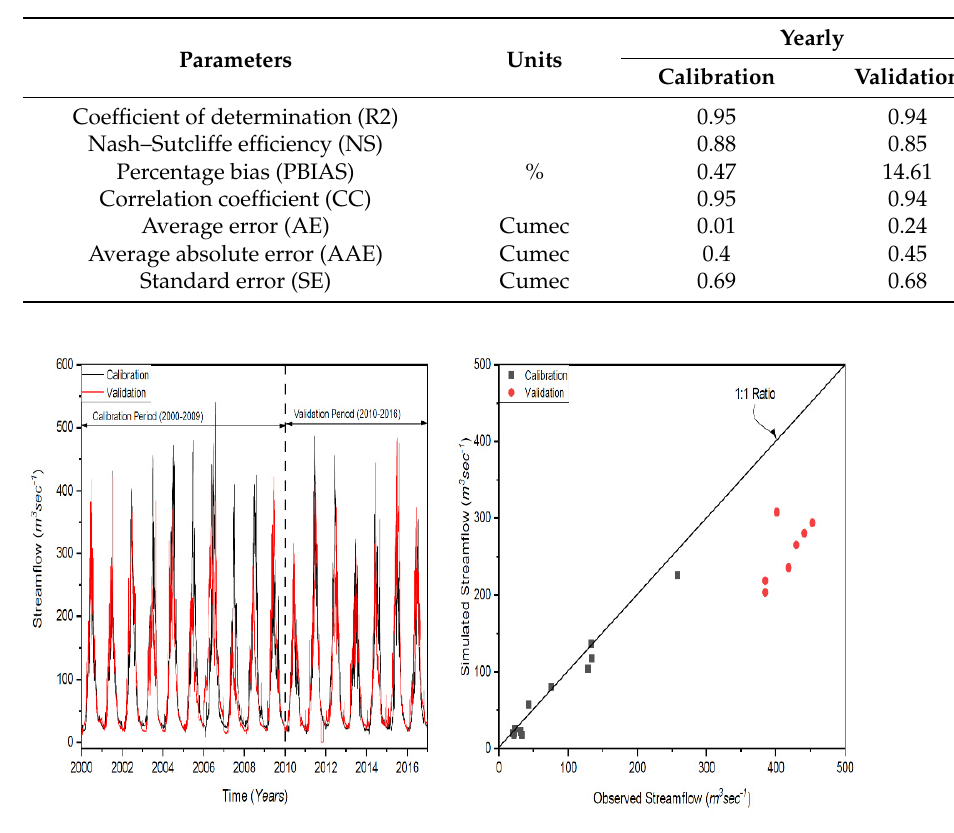
Table 5. Nash–Sutcliffe efficiency (NSE), coefficient of determination (R2), and percentage bias (PBIAS) for calibration (2000–2009) and validation (2010–2016) with the stream gauges in the Kunhar